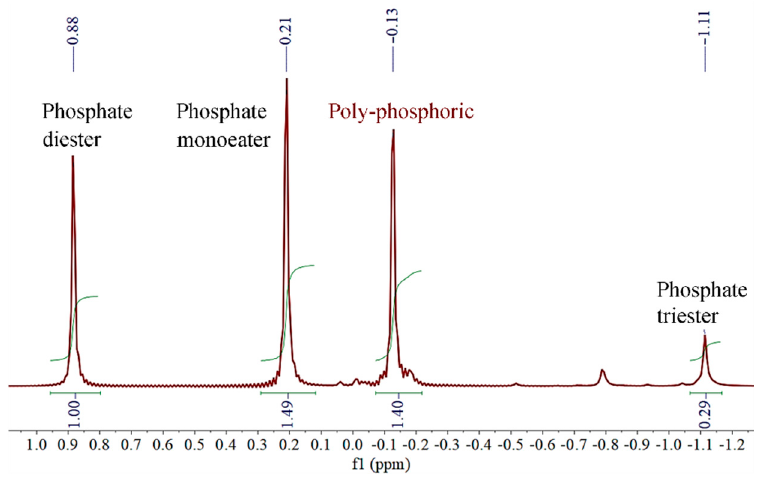
Figure 2. 31 P NMR of HPN monomer.